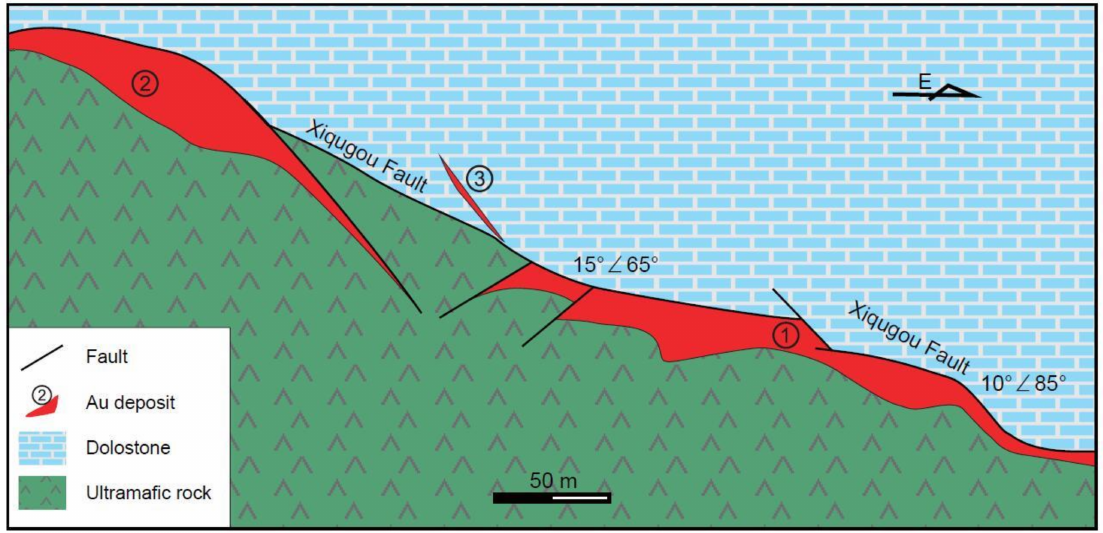
Figure 3. Cross-section of the of the Jianchaling Au deposit at a 870 m elevation showing the relationship of the mineralisation and fault